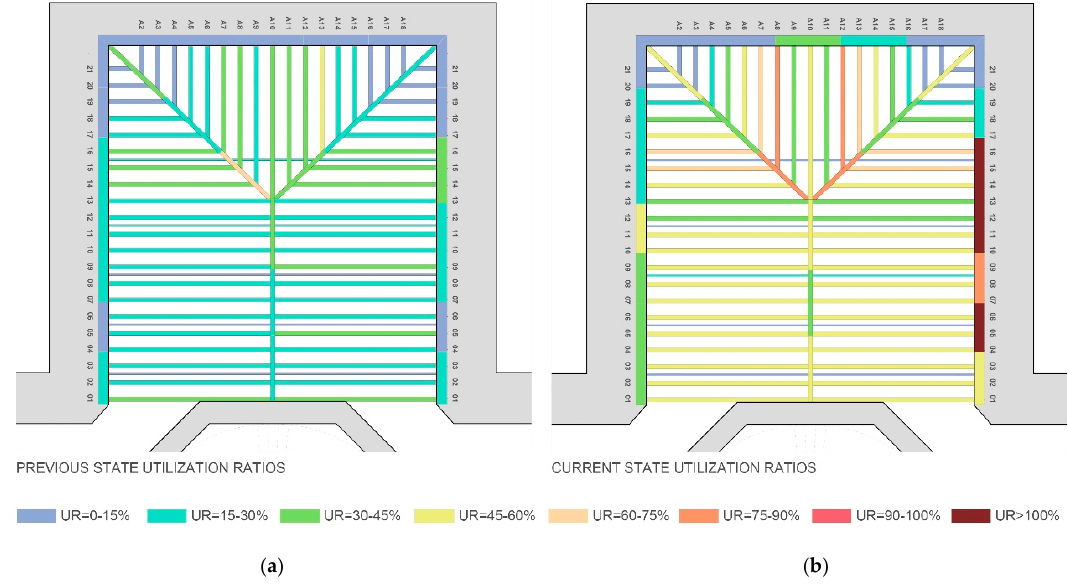
Figure 21. ( a ) Comparison of URs of the previous and ( b ) of the current state